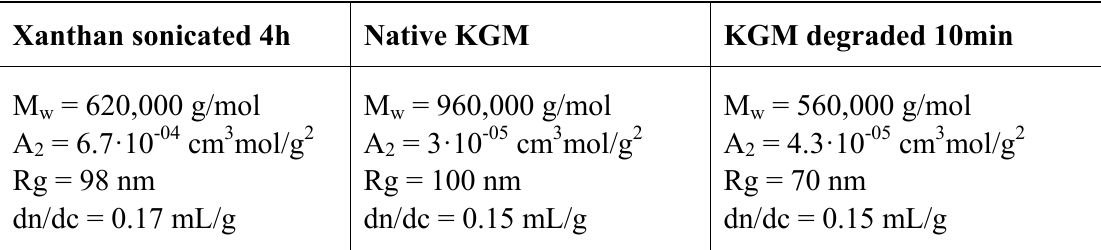
Table 1. Molecular parameters of Xanthan and